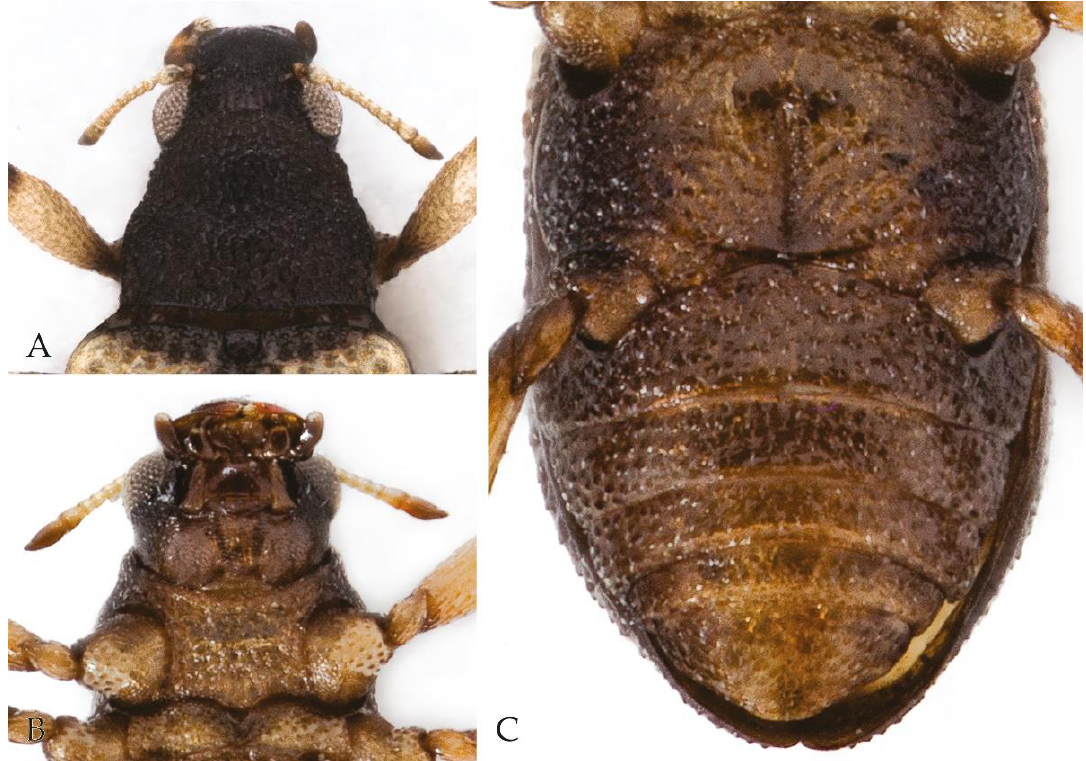
Figure 3. Ancyronyx jhoanae sp. nov.: ( A ) anterodorsal aspect with head and pronotum; ( B ) anteroventral aspect with head, prosternum, and mesoventrite; ( C ) and posteroventral aspect with metaventrite and ventrites 1 – 5.